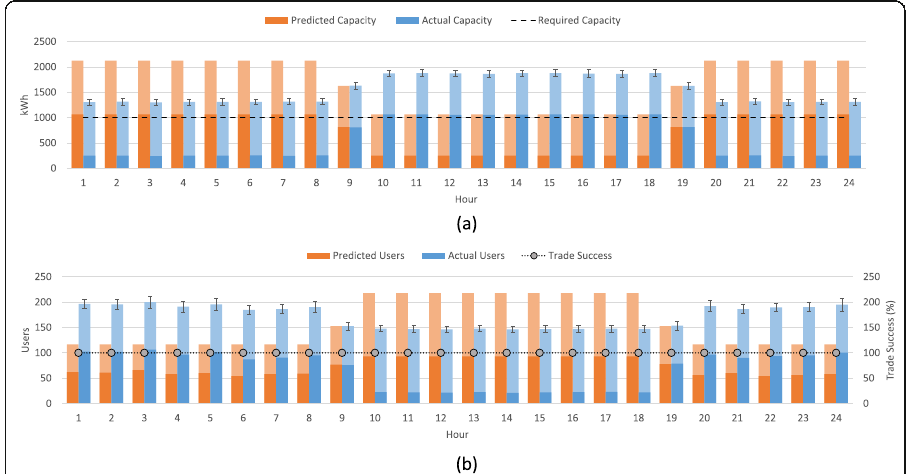
Fig. 13 Results from 100 simulated trades at iteration 40 of the experiment i.e. prior to any learning. Description as for Fig.